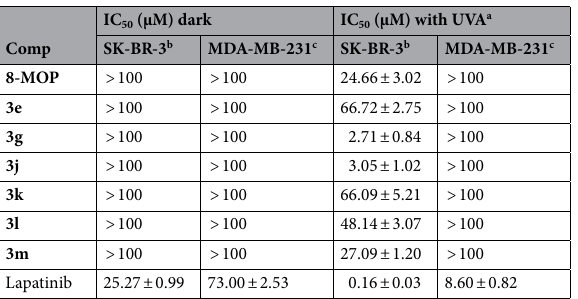
Table 2. Dark and light-activated cytotoxicity of psoralen derivatives against breast cancer cells. Results are obtained from three independent biological repeats; a Irradiation with UVA (2.0 J cm −2 ); b HER2+ breast cancer; c HER2− breast